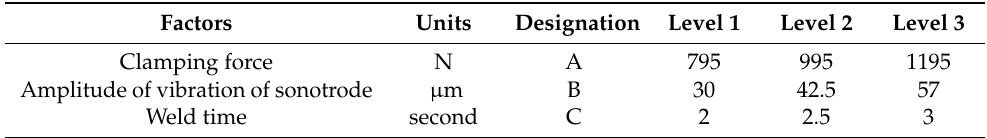
Table 1. Factors and levels.